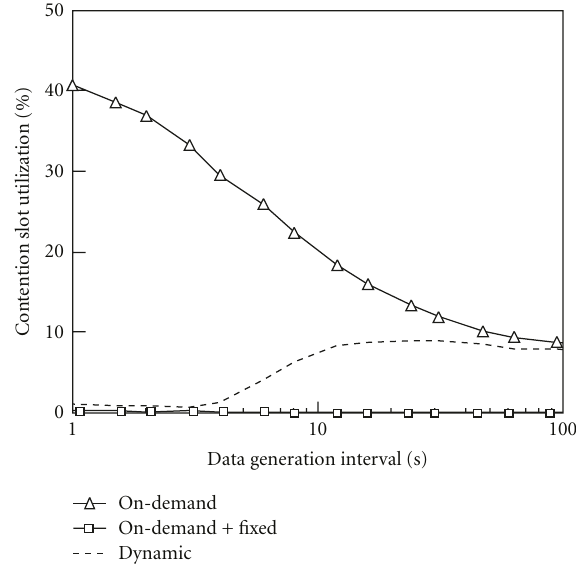
Figure 18: Contention slot utilization with di ff erent contention- free slot allocation methods.